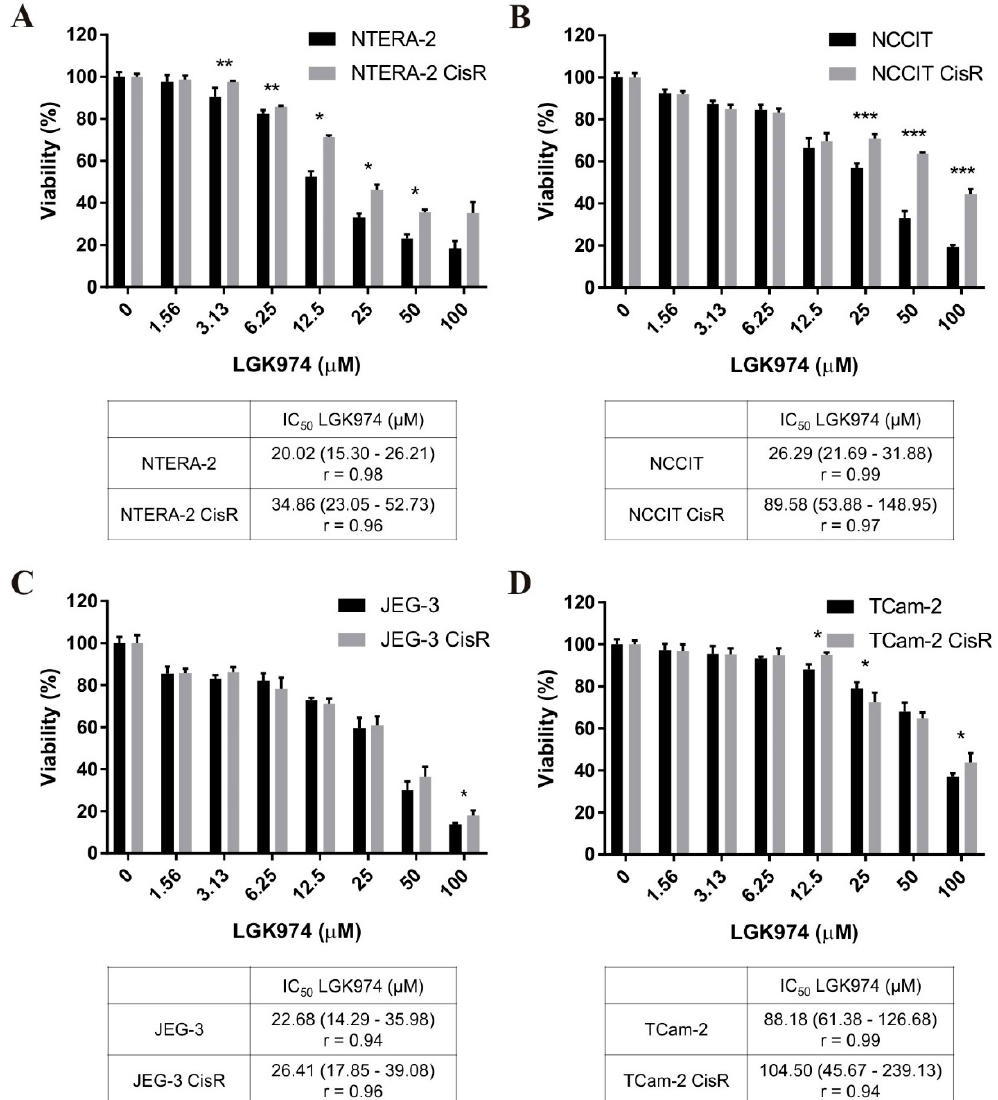
Figure 4. Cisplatin-resistant GCT cell lines were more resistant to LGK974 treatment compared to parental cells or there were no significant differences. ( A – D ) The effect of LGK974 treatment in parental and resistant GCT cell lines was determined by luminescent viability assay on day 3. Values were expressed as the averages of quadruplicates ± SD and IC 50 values were stated in tables below graphs. * p < 0.05, ** p < 0.01, *** p < 0.001.